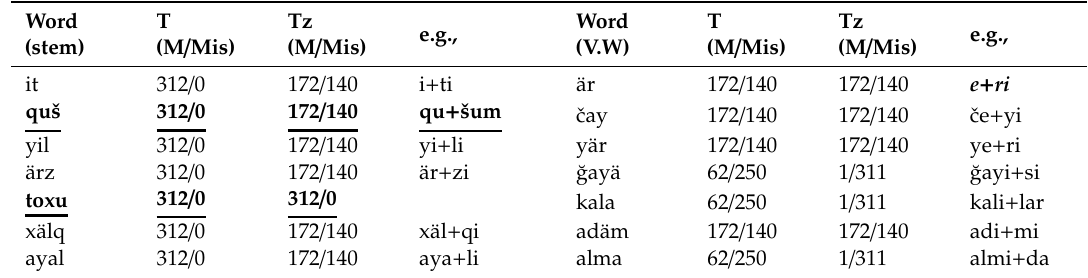
Table 3. Word morphology matching